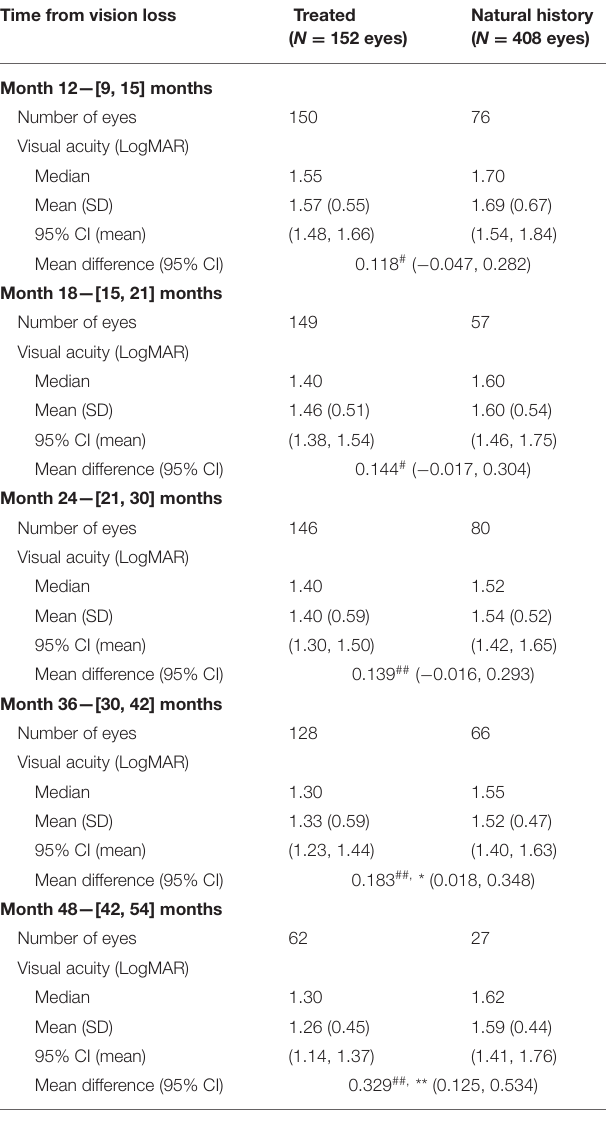
TABLE 2 | Visual acuity of treated eyes vs. natural history eyes with time intervals from vision loss. Time from vision loss Treated ( N = 152